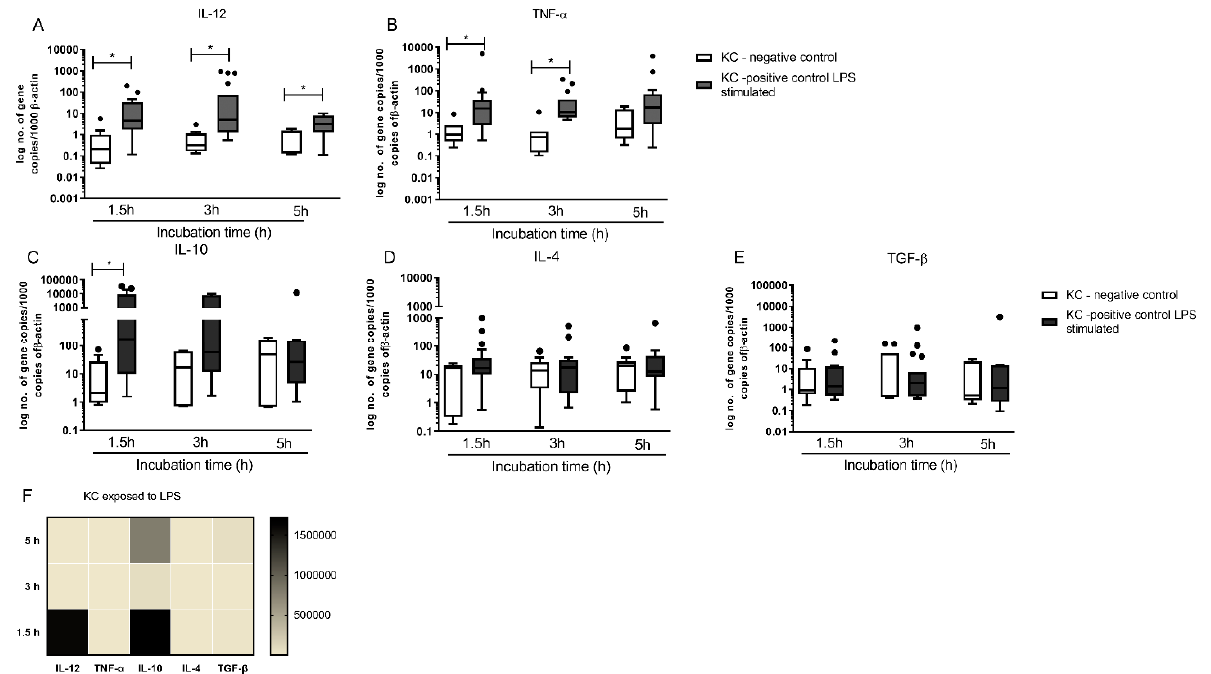
Figure 7. Kupfer cells respond to LPS. Cytokine gene expression of KCs stimulated by LPS for 1.5 h, 3 h and 5 h were evaluated by RT-PCR [IL 12 ( A ), TNF- α ( B ), IL 10 ( C ), IL-4 ( D ), and TGF- β ( E )] and results expressed by whisker box-plot (Tukey) ( n = 10). Outlier values are indicated by black dots. The non-parametric Wilcoxon test was used for statistical comparisons. * ( p < 0.05) indicate significant differences. The relative accumulation of pro-inflammatory and anti-inflammatory cytokine mRNA by LPS stimulated-KCs is represented by heat map ( F ).